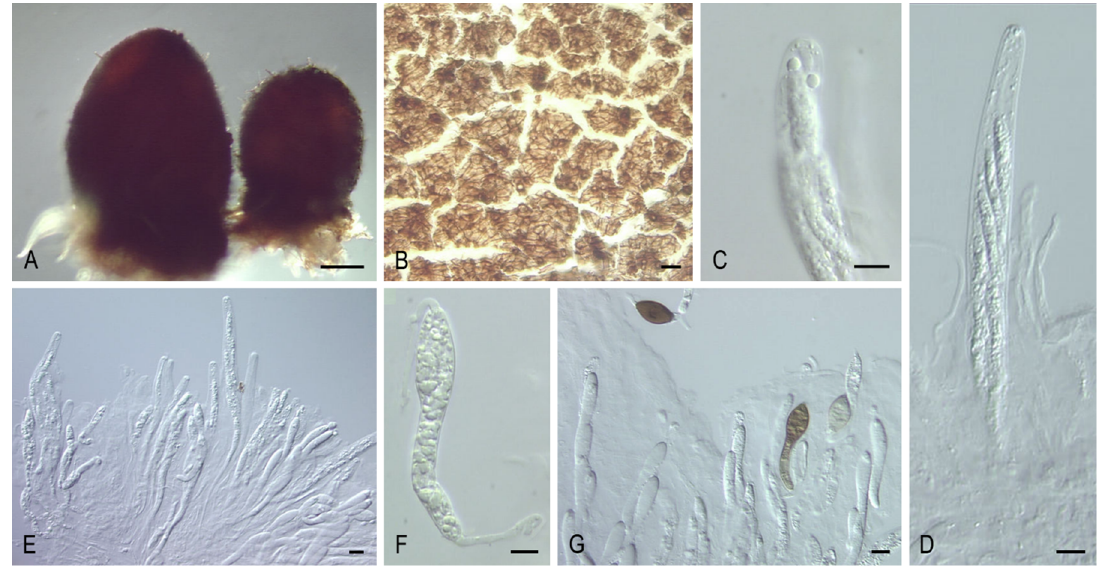
Figure 8. Podospora costaricensis GC 73. ( A ) Ascomata. ( B ) Ascomatal wall. ( C ) Ascal apex. ( D , E ) Asci. ( F , G ) Ascospores. Bars: ( A ) = 100 µm; ( B – E , G ) = 20 µm; ( F ) = 5 µm. Podospora sacchari (B.M. Robison) Y. Marín & Stchigel, comb. nov. MycoBank MB835502. Basionym: Echinopodospora sacchari B.M. Robison, Trans. Brit. Mycol. Soc. 54: 320. 1970.